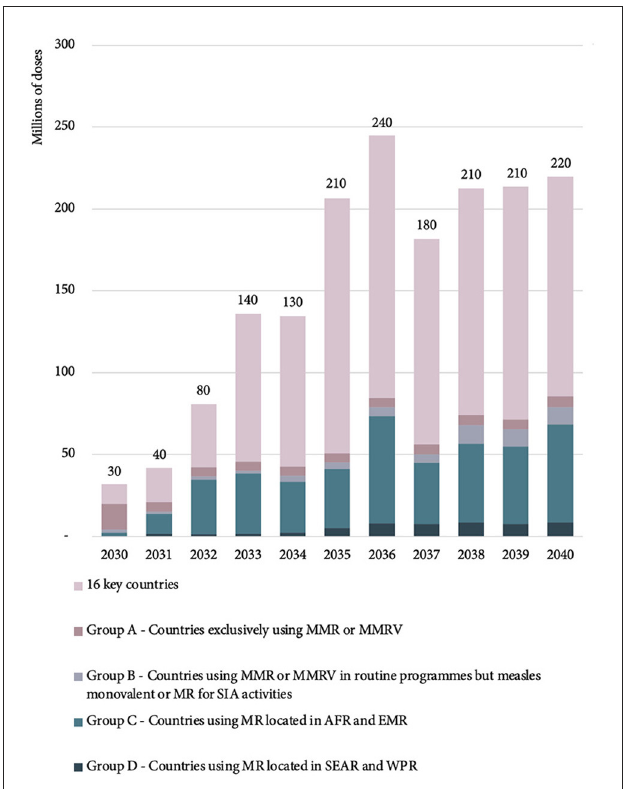
FIGURE4 Estimated global MR-MAP PDR—by country group, between 2030 and 2040. MR, measles and rubella; MAP, microarray patches; PDR, programmatic doses required; SEAR, WHO South East Asia Region; WPR, WHO Western Pacific Region; AFR, WHO African Region; EMR, WHO Eastern Mediterranean Region; MMR, measles, mumps, rubella; MMRV, measles, mumps, rubella, varicella; and SIA, supplementary immunization activities.